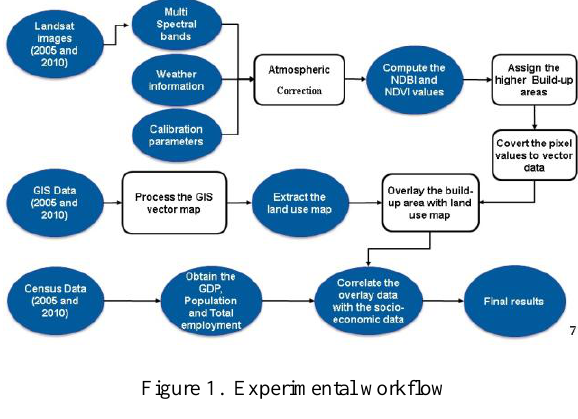
Figure 1. Experimental workflow